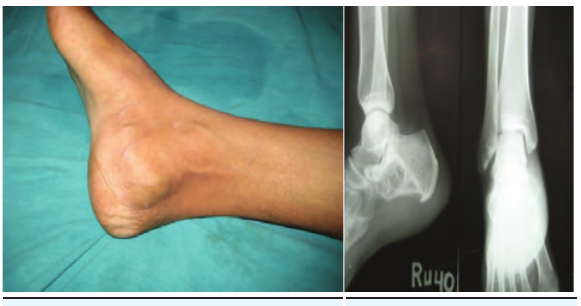
Figure 2. plain X-ray lateral view.